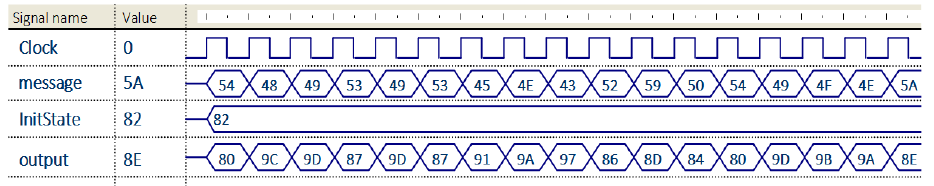
Figure 10. An 8-bit 90/150 LHCA output waveform for the encryption process (decimal form).